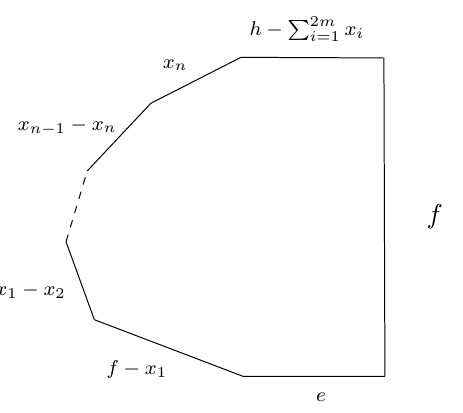
Figure 5 . A non-generic blow-up of F m as explained in the text. The edges represent curves inside the